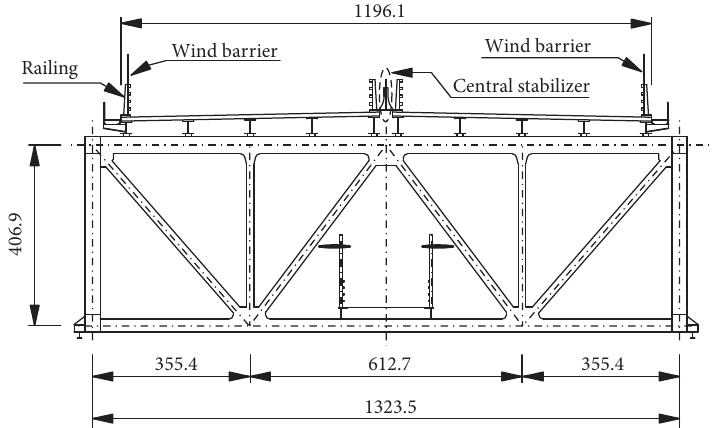
Figure 3: Scaled model of the bridge section (units: mm).